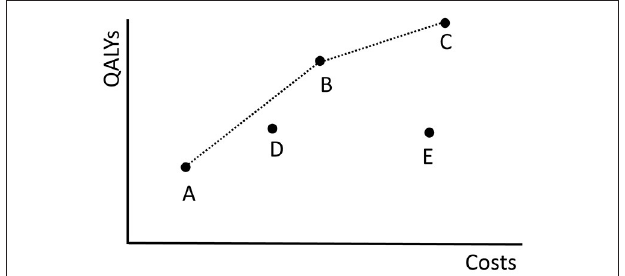
FIGURE 2 | The costs of and QALYs gained by the fictive screening policies in 5 = { A , B , C , D , E } are plotted. The dotted black line shows the objective values of the policies in the approximation set ψ ( 5 ). The minimal representation of ψ ( 5 ) is { A , B , C }